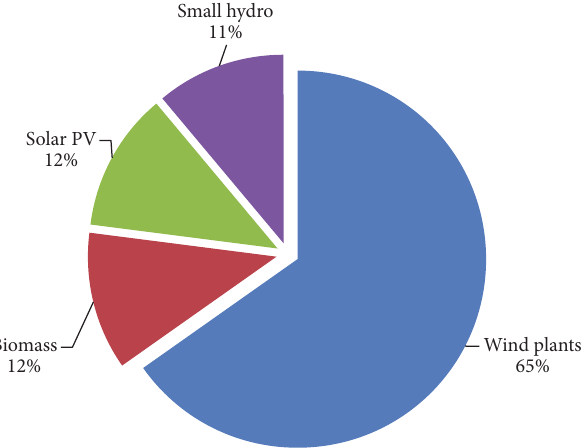
Figure 1: Grid interactive power generation.